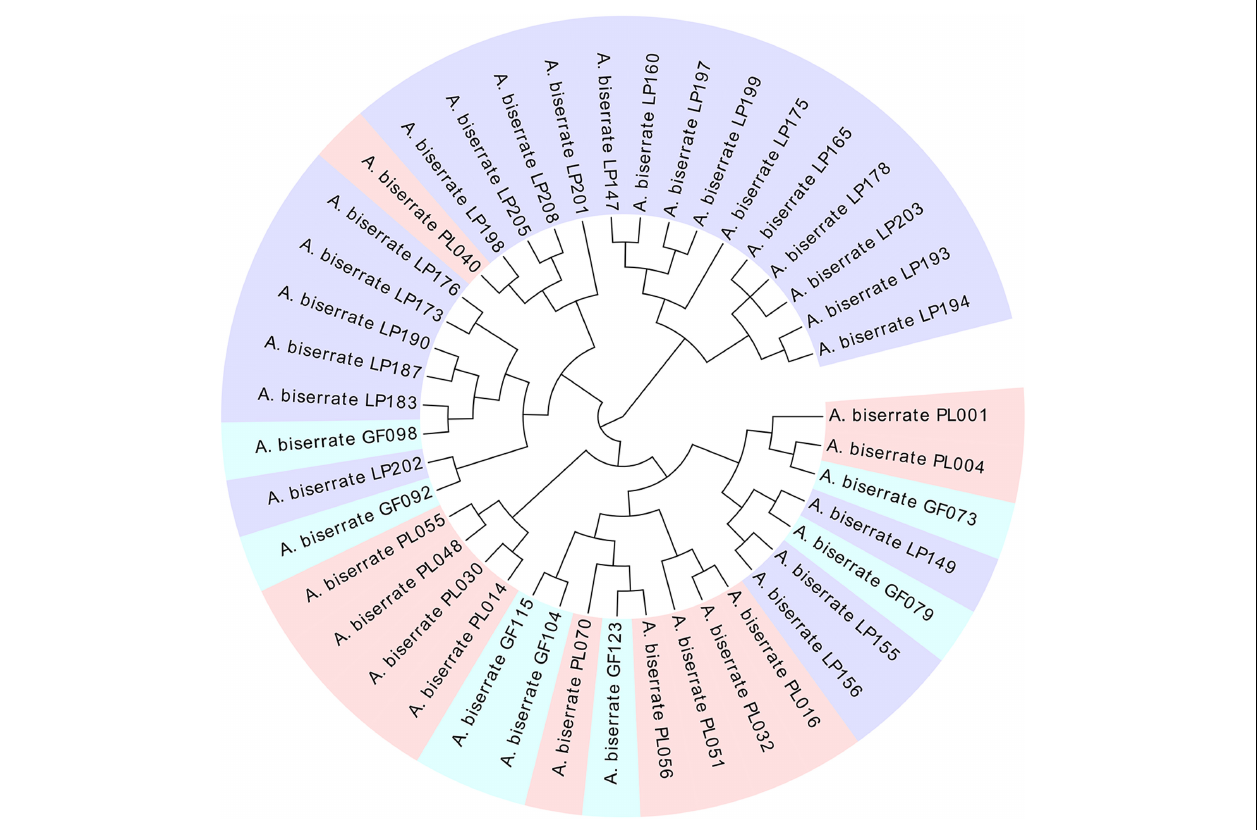
FIGURE 5 | The cluster tree of the core collection (20CC) consisted of 42 germplasms. Light pink, blue, and purple colors represent germplasms collected from Puling, Gaofeng and Langping,